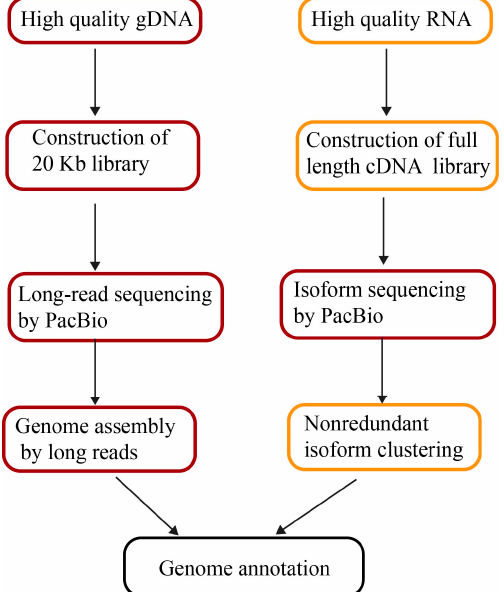
Figure 1. The pipeline of genome assembly and annotation by long reads. gDNA: genomic DNA; cDNA: complementary DNA.